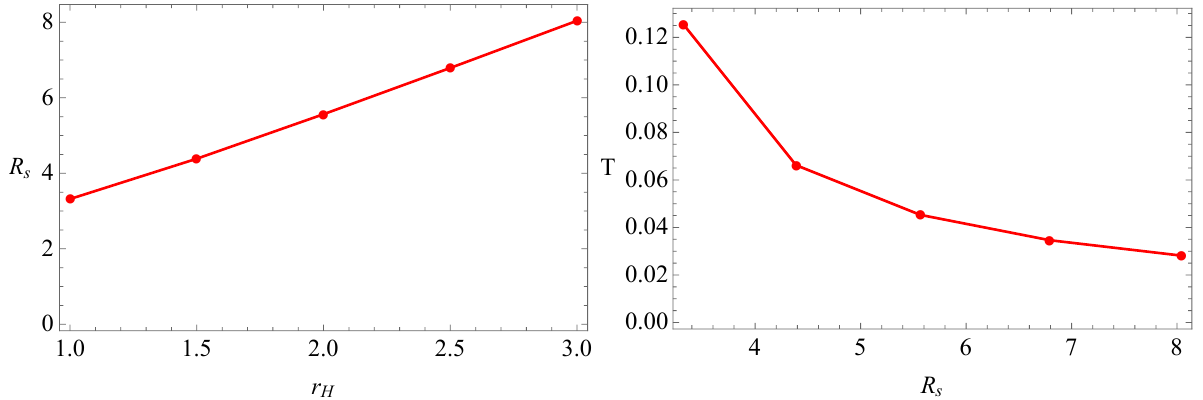
Figure 6. Left panel : The typical shadow radius of the spinning quantum deformed BH viewed in θ o = 0 as a function of the event horizon radius. Right panel : The Hawking temperature of the spinning quantum deformed BH as a function of typical shadow radius. We have set a / M = 0.65 and b / M = 0.5.